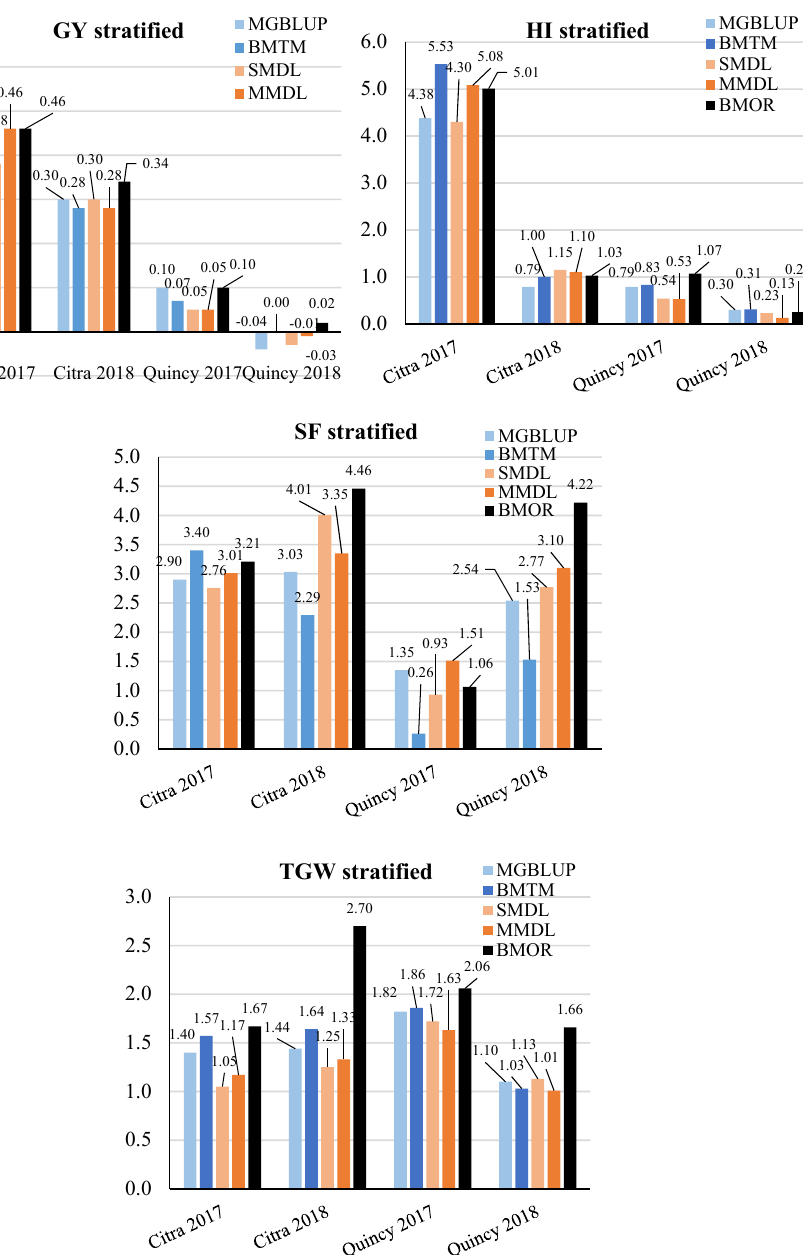
16 of 26 Figure 7. Response to selection for GY (t ha − 1 ), HI (%), SF (grains/g chaff weight), and TGW (g) without population stratified. GY, grain yield; HI, harvest index; SF, spike fertility; TGW, thousand grain weight. Response to selection for each environment was presented and labeled for each trait. Statistical models were colored in light blue and blue, while DL models were colored in light orange and orange. The BMOR model was colored in black.